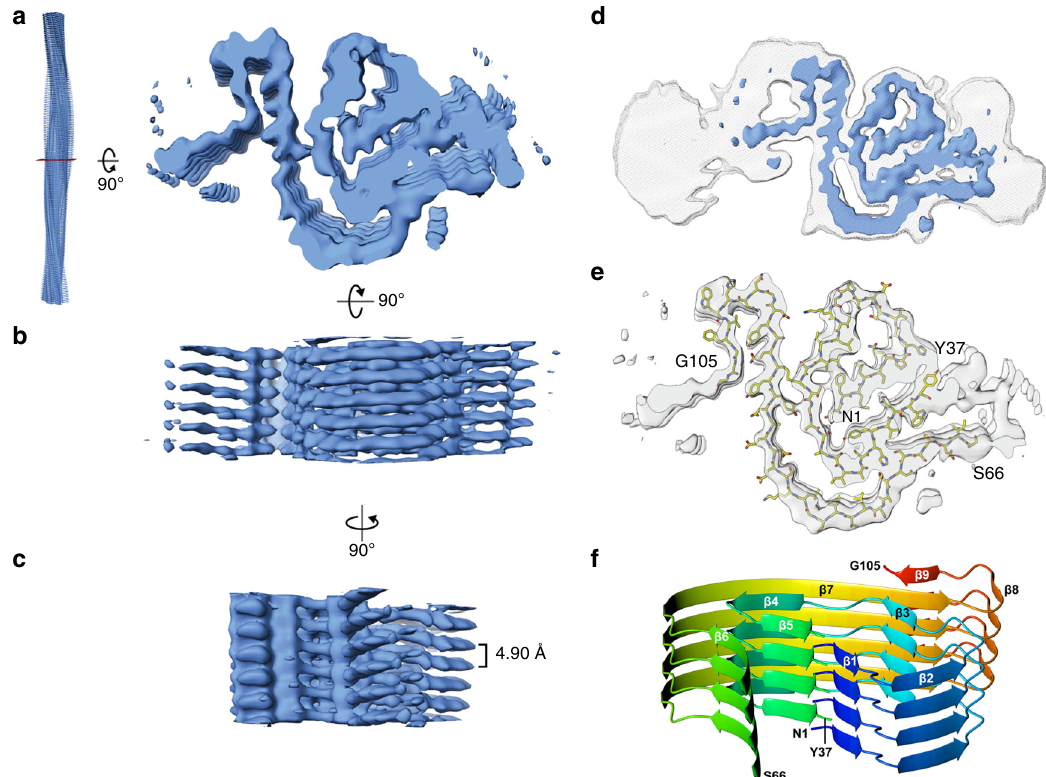
Fig. 2 Structure of AL55 amyloid fi brils. a – c Orthogonal views of the post-processed 3D reconstruction at overall resolution of 4.0 Å (FSC = 0.143). d Overview of the AL55 fi bril cryo-EM map covering the structured fi bril core region (blue). Cross-sectional EM densities of sharpened, 4.0 Å (blue) and unsharpened, 4.5 Å low-pass fi ltered (gray) reconstructions. e Atomic model of AL55 (residues 1 – 37 and 66 – 105) superimposed on a cross-section of the EM density map. f Ribbon representation of the fi bril structured core, rainbow colored. Four stacks (subunits) in the typical cross- β arrangement are